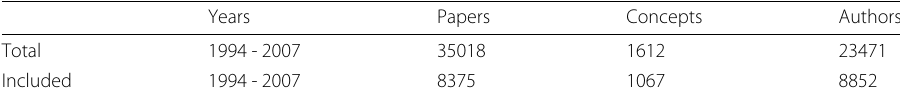
Years Papers Concepts Authors Total 1994 - 2007 35018 1612 23471 Included 1994 - 2007 8375 1067